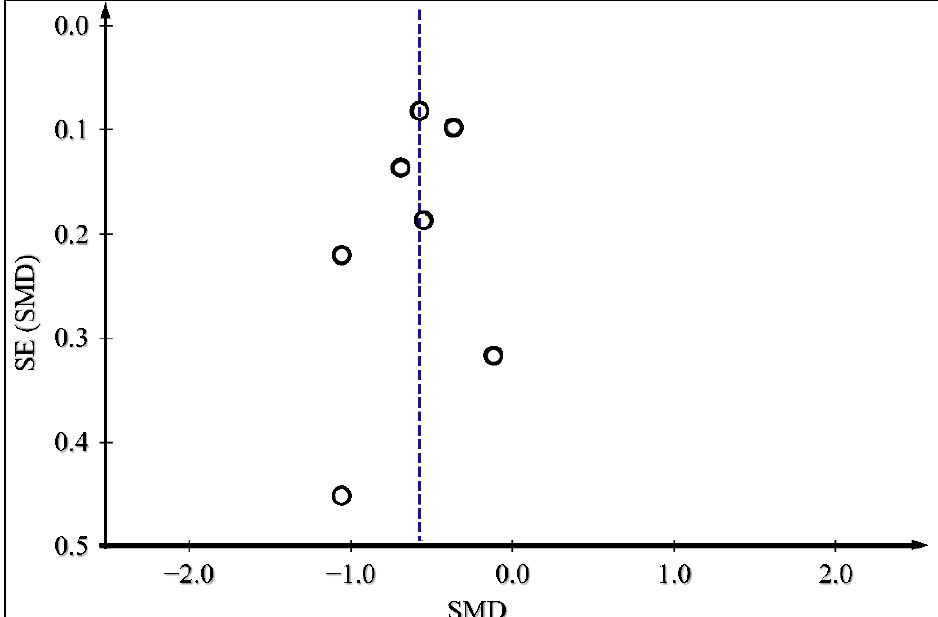
Figure 10. Funnel plot for Publication Bias Assessment for Daily Insulin Dose.